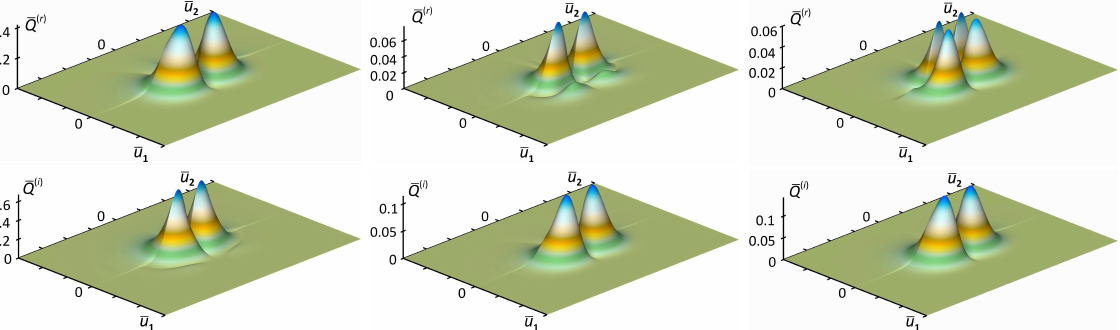
Figure 6. Distributions of environmental fields in the process of evolution, respectively, at time points t 1 = 1.5, t 2 = 10 and t 3 = 20. The calculations are performed for the case ε ( r ) = ε ( i ) = 1, when processes, both elastic and inelastic, are strongly